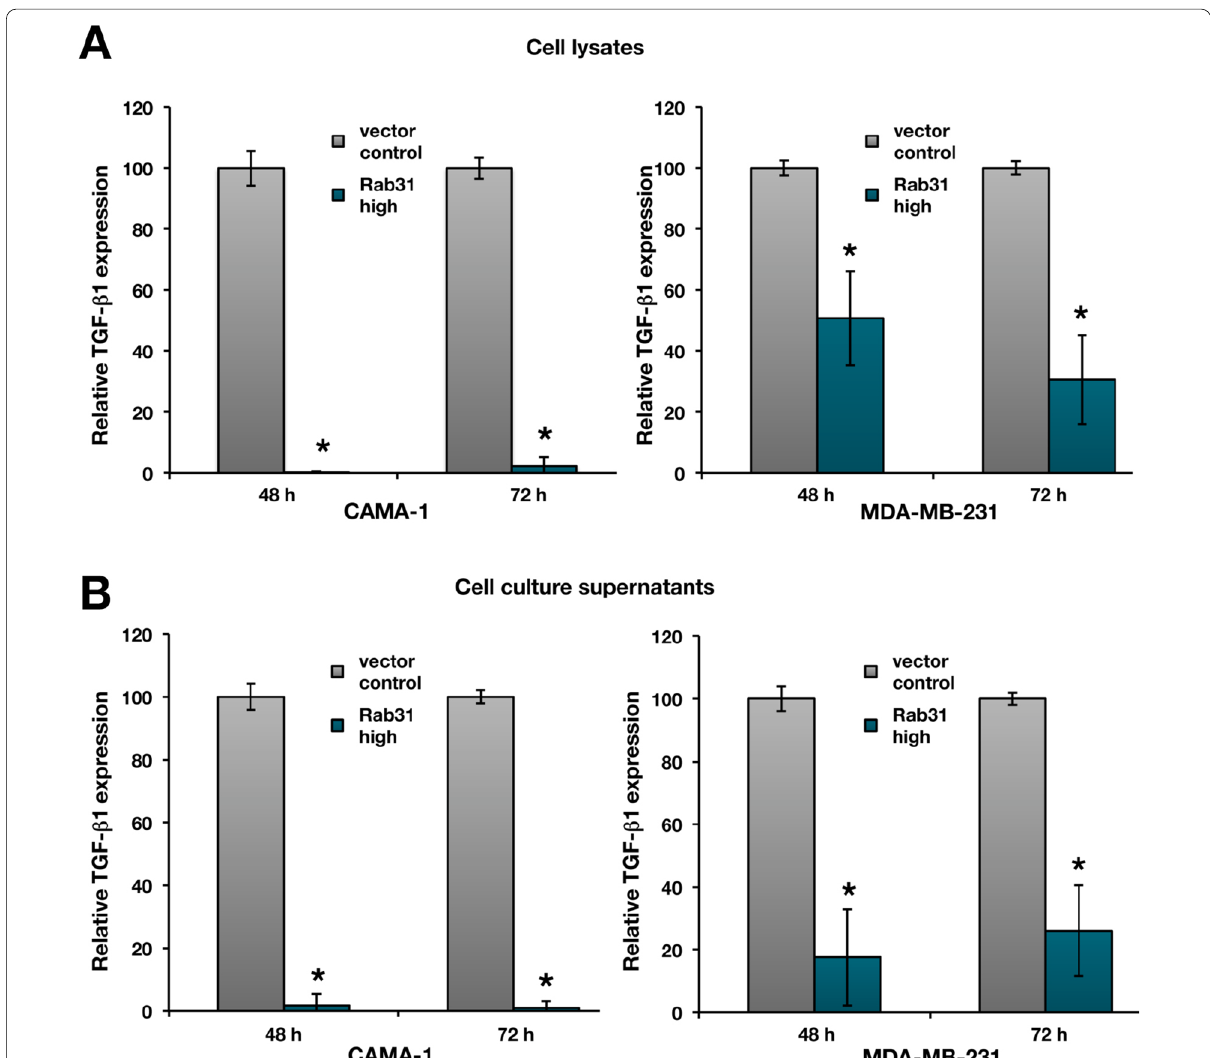
Fig. 5 Relative TGF-ß1 antigen levels in cell culture supernatants and cell lysates from Rab31 low and high expressing cells. Cells were grown for 48 h or 72 h in FCS-free medium. TGF-β1 antigen levels from cell lysates ( A ) or from cell culture supernatants ( B ) were determined by ELISA and normalized to the total protein content of the respective sample. Three experiments were performed in triplicates each. Statistically significant differences (p < 0.05) are indicated by an